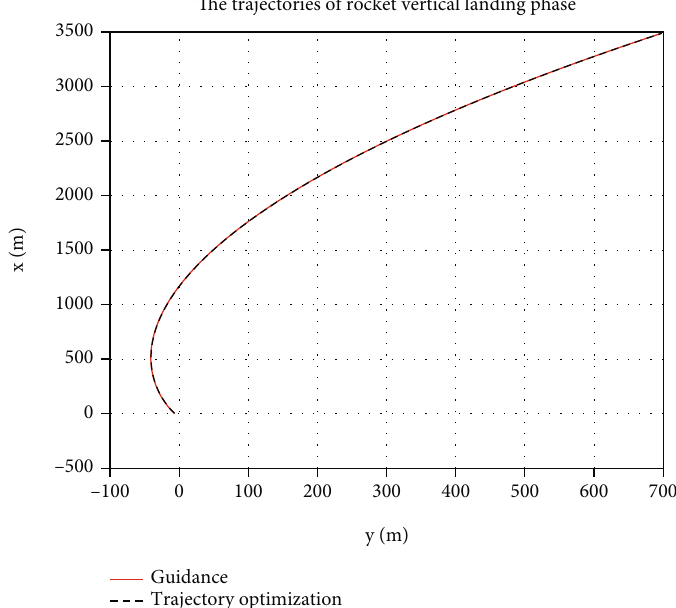
Figure 4: The trajectories of rocket vertical landing phase obtained by the guidance method and the trajectory optimization algorithm.